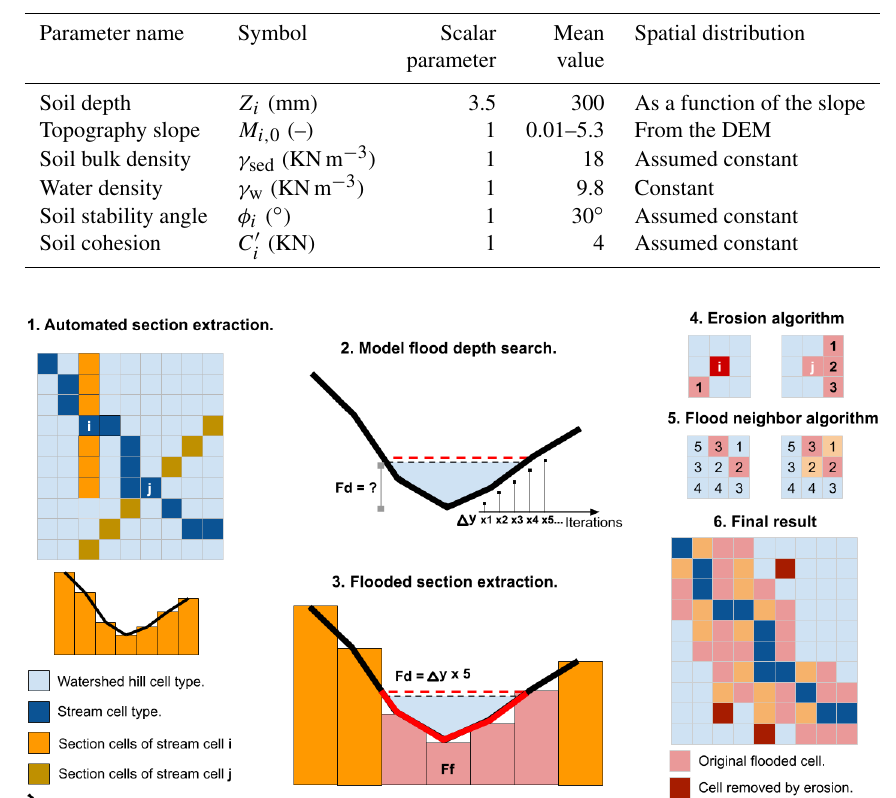
assumed to be constant and equal to 0.75 (Obrien,